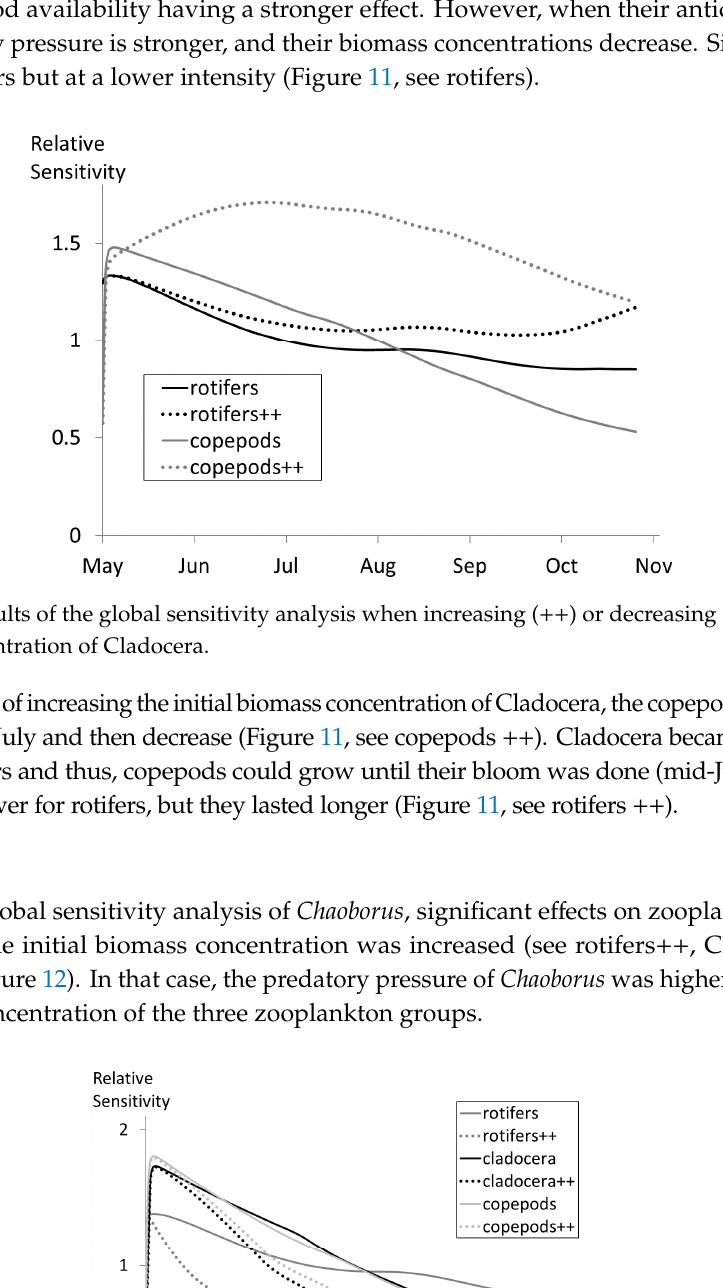
Figure 12. Results of the global sensitivity analysis when increasing (++) the initial biomass concentration of Chaoborus .